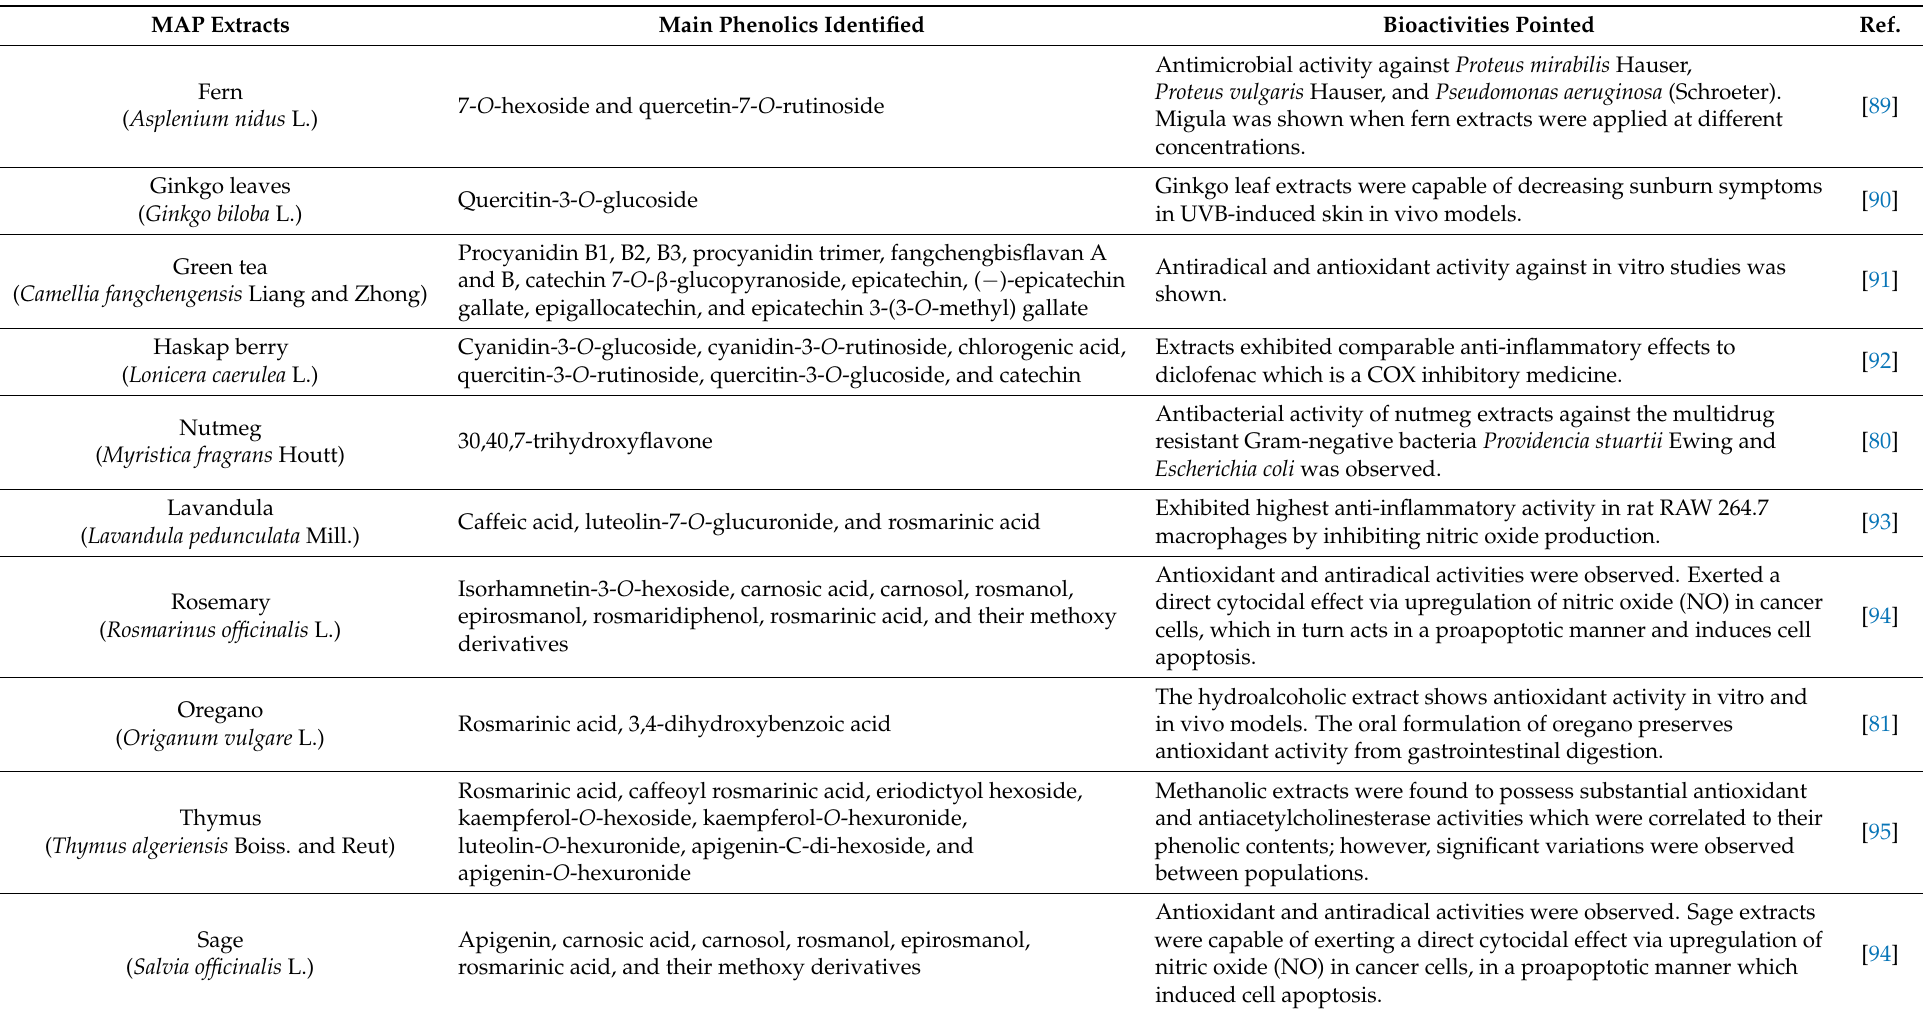
Table 3. The key role of some important phenolics identified in some medicinal and aromatic plant (MAP) species extracts and respective